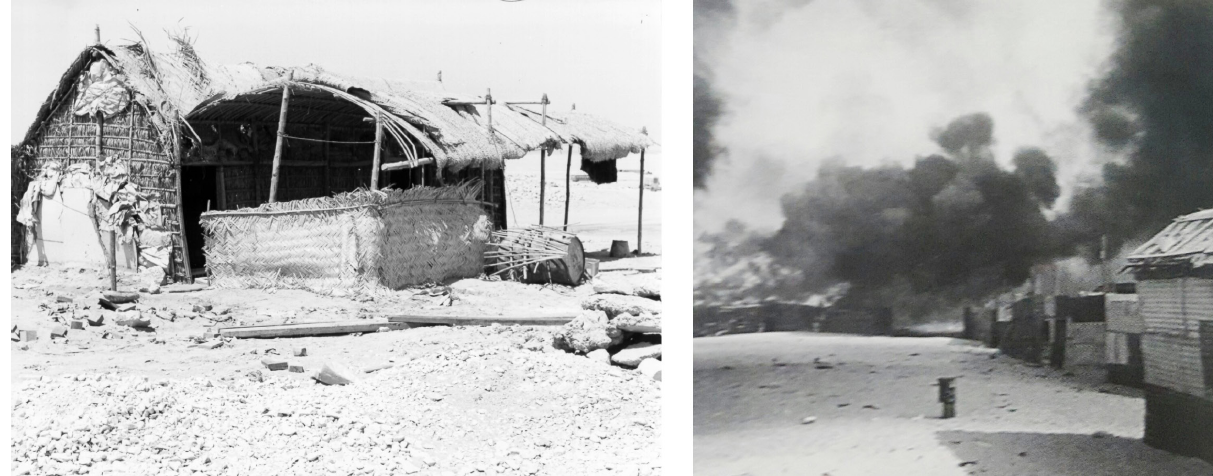
Fig. 2 Housing Conditions in the Saudi camps. Left: A ramshackle house within the Saudi camps. Source: King Abdulaziz Foundation for Research and Archives (Darah). Right: Saudi houses during a fire in early 1950s (this fire was one of the main reasons to ask for better living conditions). Source: Pho- tographer unknown, included in Abqaiq: Plants and